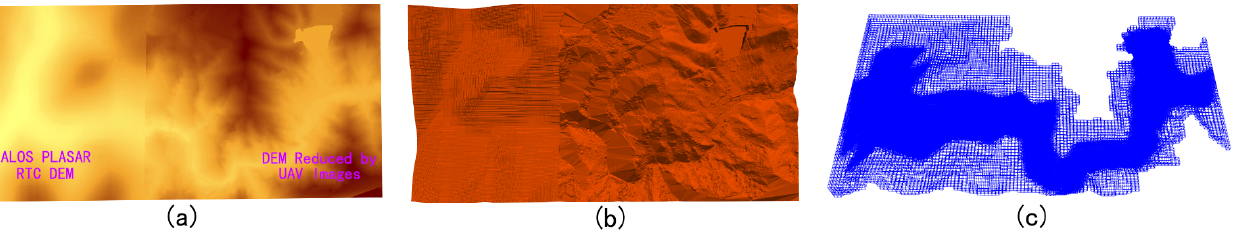
Figure 8. The 3-D terrain model around the A’xi Gold Mine. (a) The fine DEM generated by UAV (right) and ALOS satellite (left), (b) reconstructed 3-D terrain model, and (c) the computational